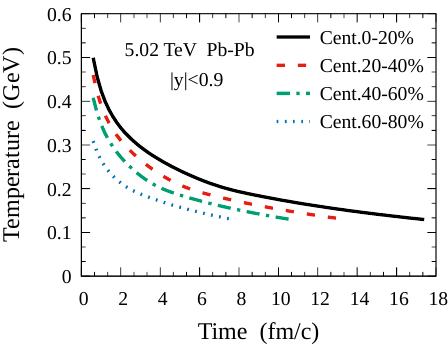
Figure 1. The time evolution of the local temperature at the center of the medium in the central √ s NN = 5.02 TeV Pb-Pb collisions. The collision centrality is chosen as 0–20%, 20–40%, rapidity in 40–60% and 60–80%. This temperature evolution is calculated with a MUSIC calculation. This figure is cited from Ref.